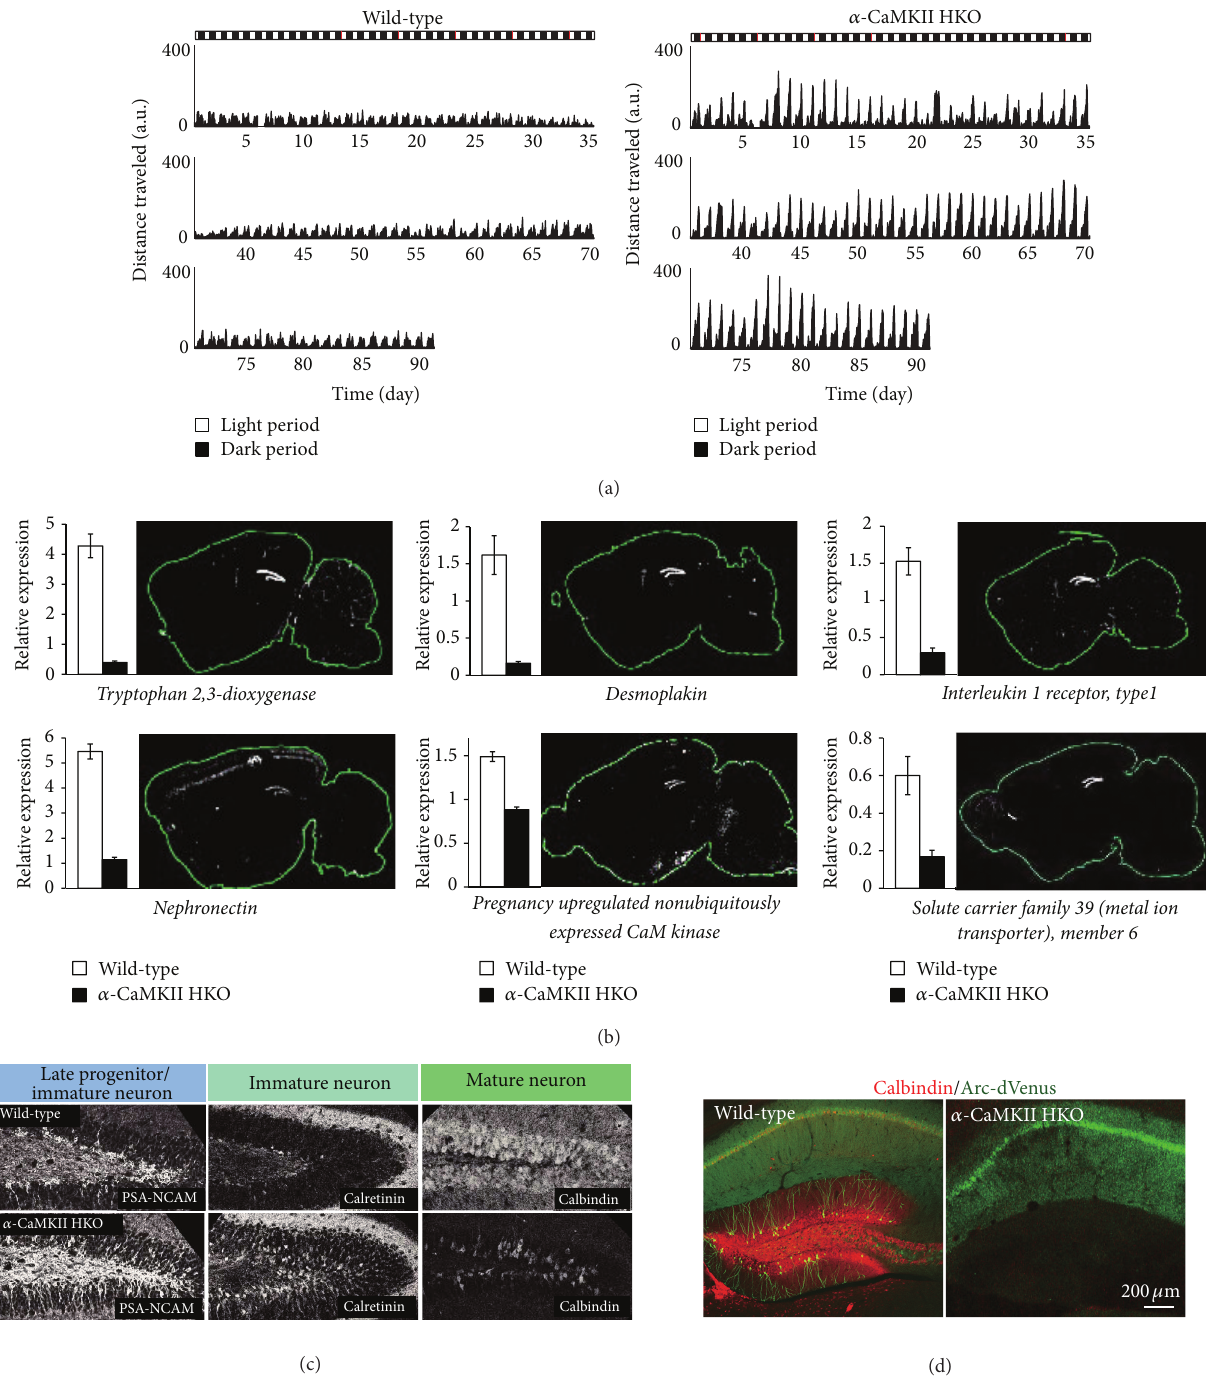
Figure 2: Mood-change-like behavior and the iDG phenotype in 𝛼 -CaMKII HKO mice. (a) Pattern of locomotor activity of wild-type and 𝛼 -CaMKII HKO mice in their home cage. Mutant mice were hyperactive and showed a periodic mood-change-like activity pattern. A.U: arbitrary unit. (b) Among the downregulated genes in the hippocampus of 𝛼 -CaMKII HKO mice, several genes were expressed selectively in the DG (Allen Brain Atlas [42]. Seattle, WA: Allen Institute for Brain Science. © 2004–2008. Available from: http://www.brain-map.org). Graphs indicate the relative expression levels of each gene in the microarray experiment. (c) In 𝛼 -CaMKII HKO mice, expression of PSA-NCAM (a late-progenitor and immature-neuron marker) and calretinin (an immature neuron marker) was markedly increased, and expression of calbindin (a mature neuron marker) was decreased. (d) Expression of Arc-dVenus in the DG of 𝛼 -CaMKII HKO mice after the working memory task (eight-arm radial maze test) was completely abolished. Red: calbindin; green: Arc-dVenus. Adapted from Yamasaki et al. [1] and Matsuo et al.